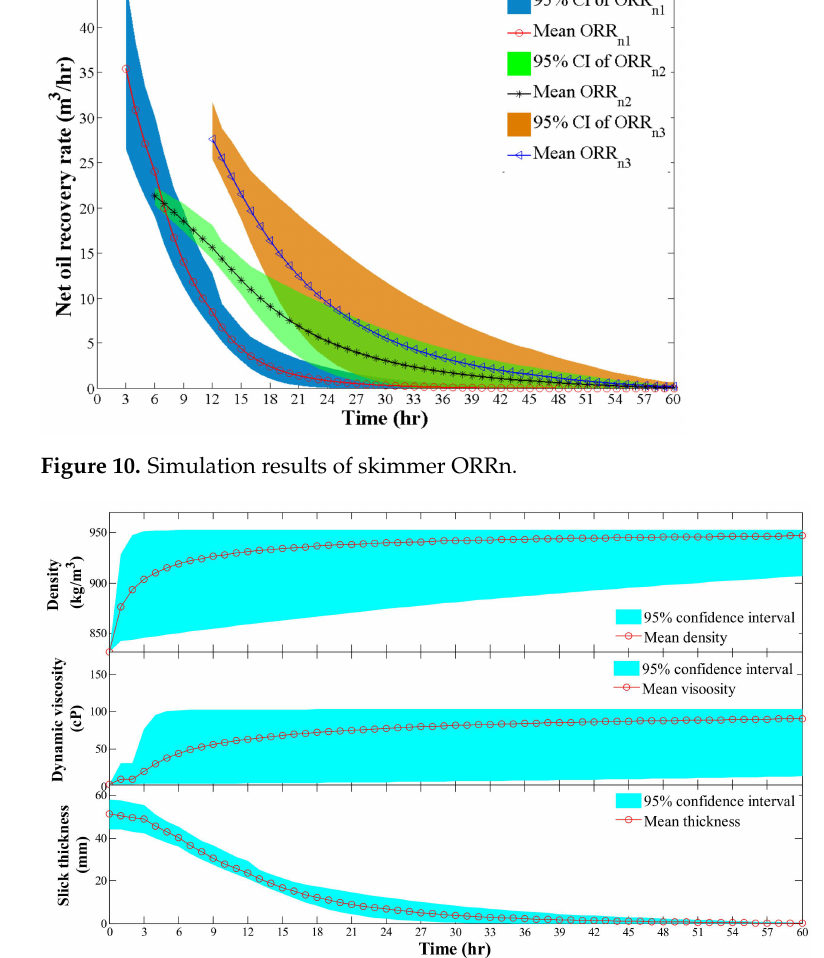
Figure 11. Simulation results of oil viscosity and density, as well as slick thickness.